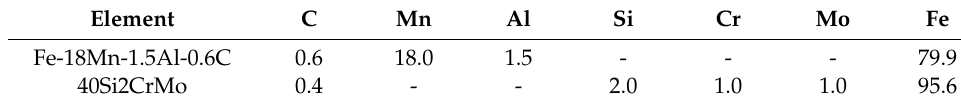
Table 1. The chemical compositions of TWIP steel and 40Si2CrMo steel [wt.%]. Element C Mn Fe-18Mn-1.5Al-0.6C